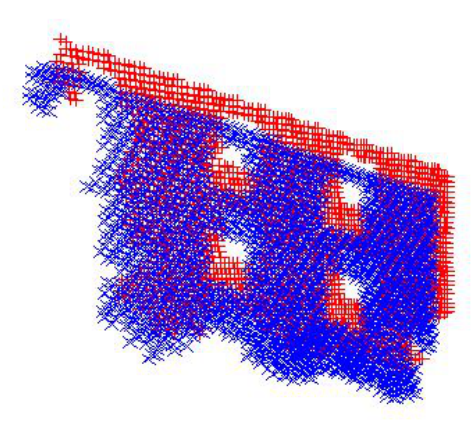
Figure 1: Point cloud of 2 different strips from overlapping area features, allows us to avoid point cloud based camera to LiDAR registration. In addition, the redundancy of the adjustment is in- creased and the geometry improved by means of including pho- togrammetric data into a LiDAR adjustment. The overall accu- racy can also be improved adding photogrammetric and LiDAR ground control